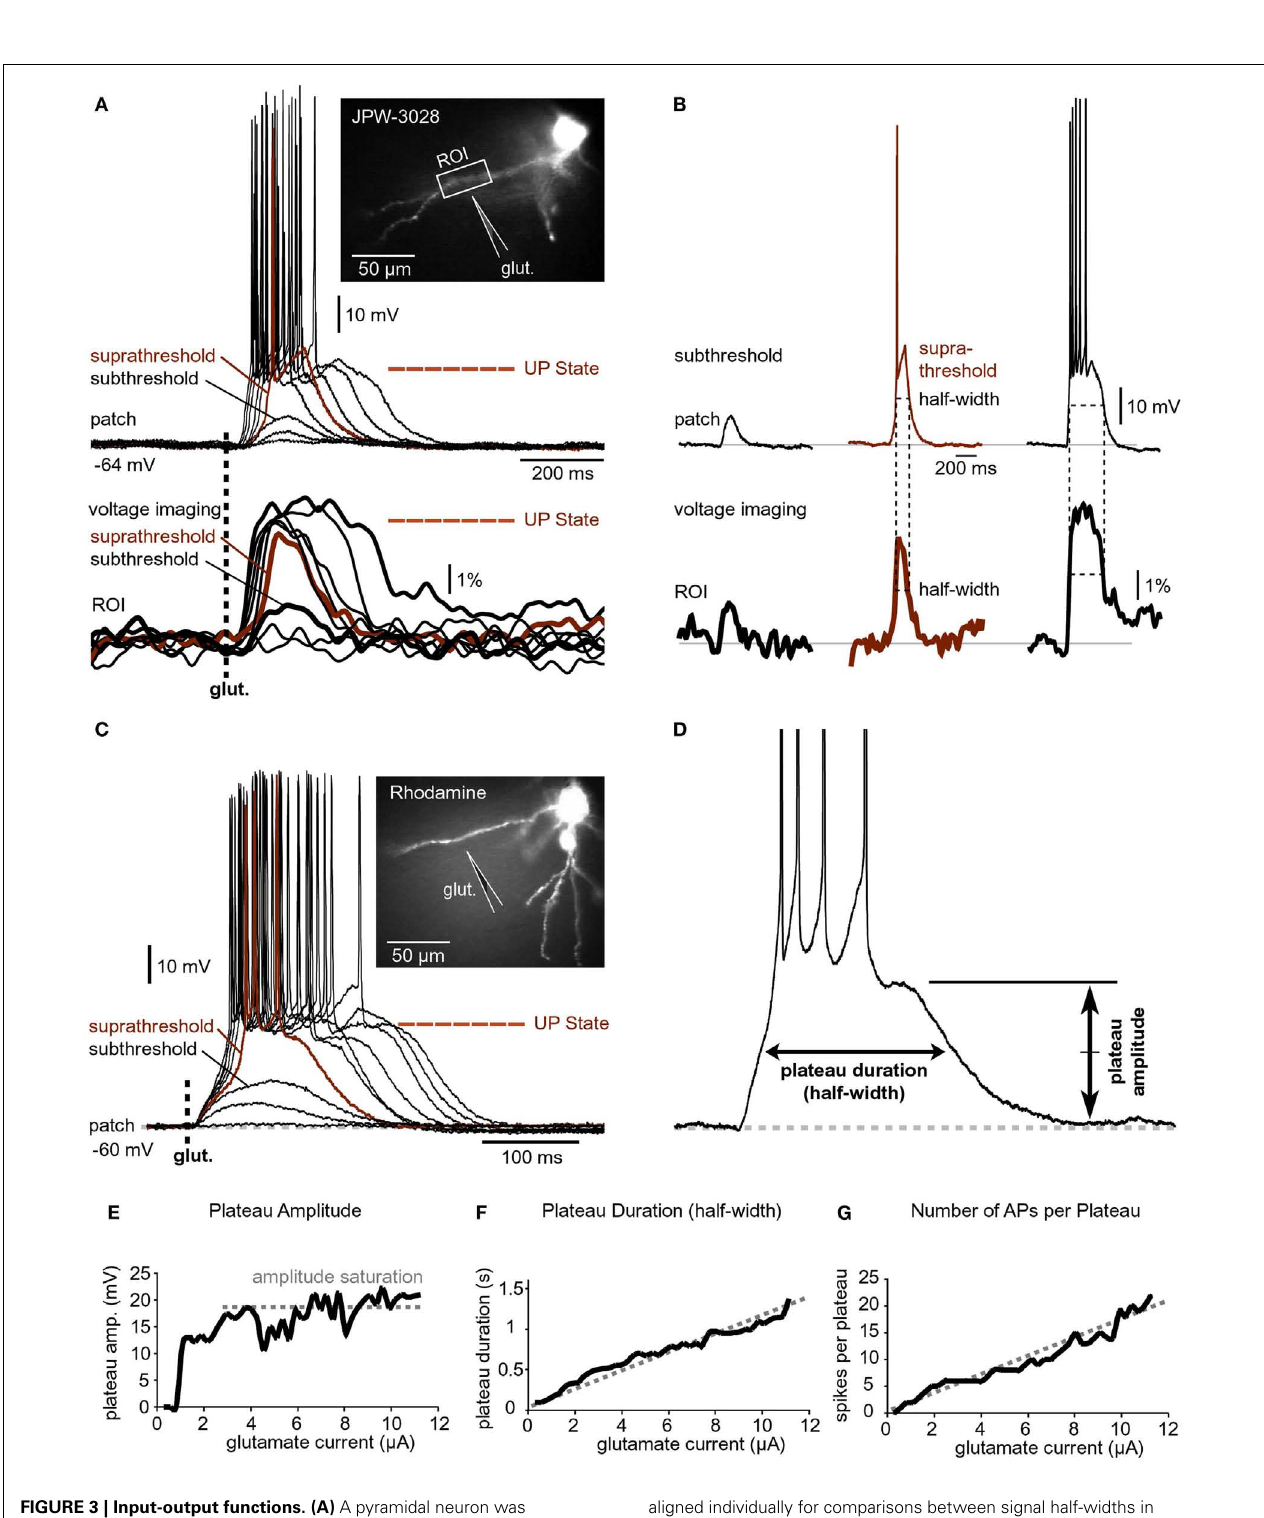
FIGURE 3 | Input-output functions. (A) A pyramidal neuron was injected with the voltage-sensitive dye (JPW-3028) and stimulated by glutamate microiontophoresis (inset). Intensity of glutamate iontophoretic current was gradually increased (fixed increment), while dendritic depolarizations were recorded optically in dendrite (ROI) and electrically in the soma (patch). Brown color marks a sudden jump – spike. (B) Three experimental sweeps selected from (A) are